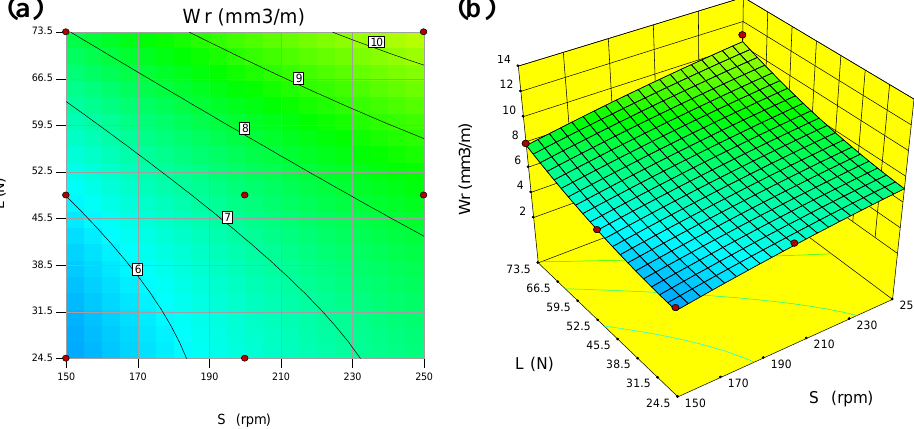
Figure 4. View of the interactive effect of S and L on the Wr ( a ) contour lines 2D, ( b ) 3D.